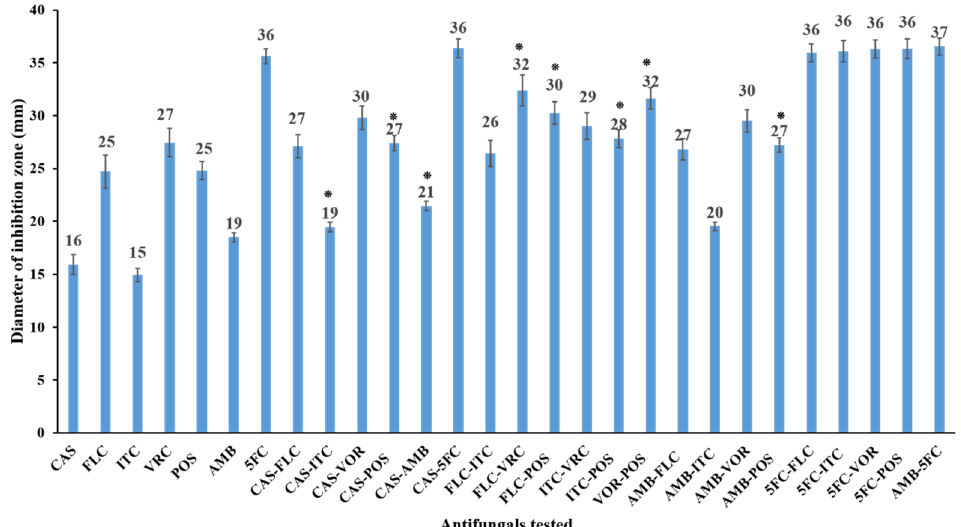
Figure 1. In vitro activities of CAS (4 µ g/disk), FLC (25 µ g/disk), ITC (4 µ g/disk), VRC (1 µ g/disk), POS (4 µ g/disk), AMB (1 µ g/disk), and 5FC (1 µ g/disk), alone and in combinations against 17 C. glabrata isolates as determined by the disk diffusion assay. The results represent the mean of inhibition zone diameters ± standard deviation of the results from two independent experiments. The combinations showing statistical significance ( p < 0.05) as compared to each corresponding single antifungal agent are marked with an asterisk (*).